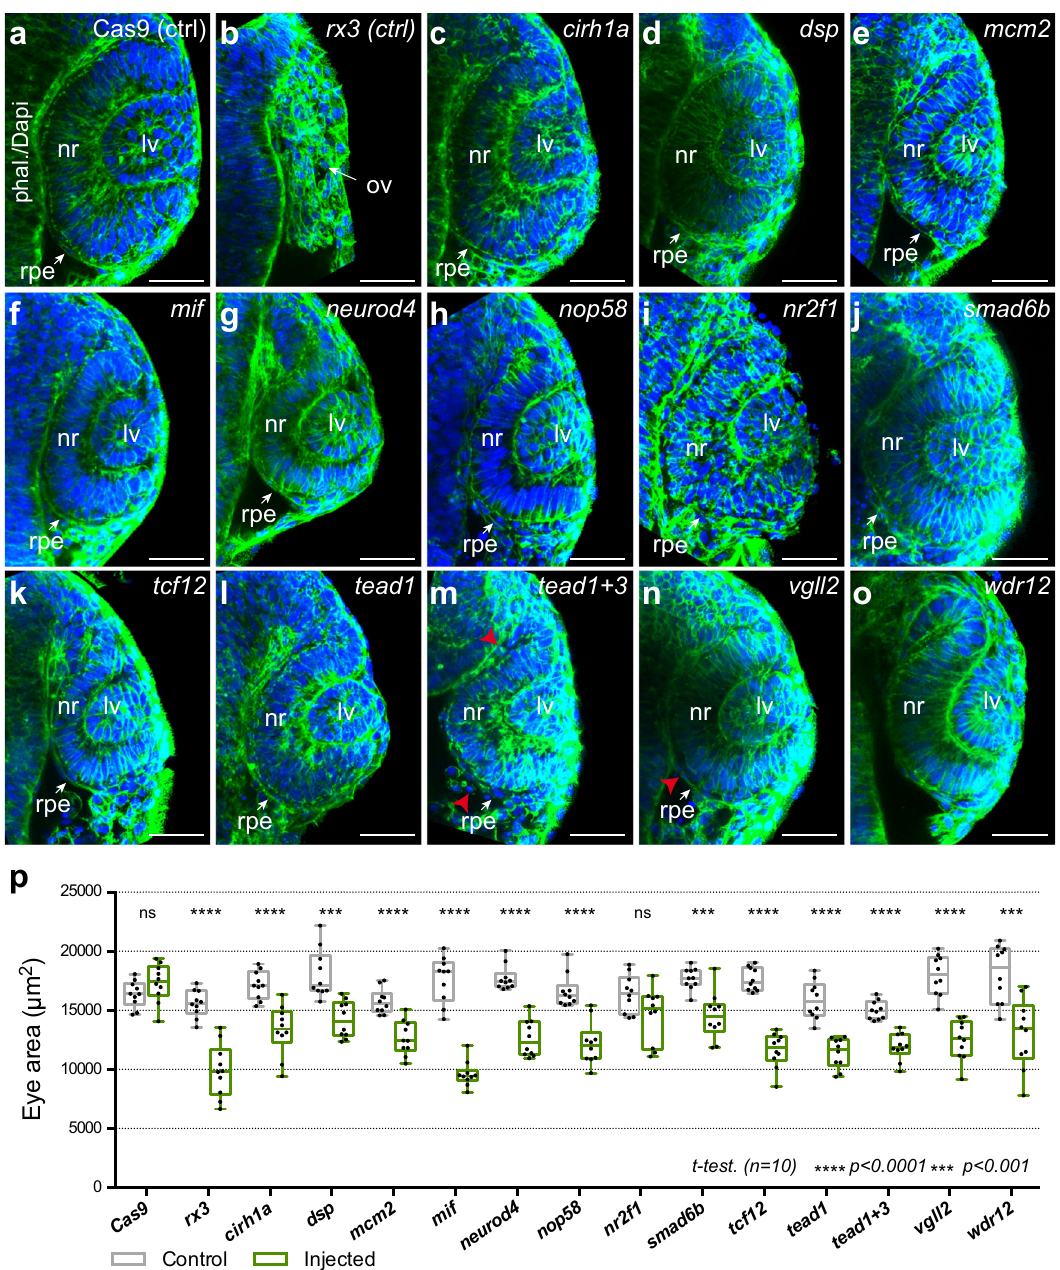
Fig. 8 Optic cup architecture and size quanti fi cation in candidate gene crispant embryos. a – o Representative optical sections through the optic cup of crispant 24 hpf embryos. Phalloidin/DAPI staining reveals tissue organization of control embryos injected only with Cas9 ( a ), with sgRNAs directed against rx3 ( b ), or with sgRNAs for the different candidate genes (indicated in ( c ) – ( o )). Note that, in contrast to rx3 crispant embryos, the optic cup is formed in all cases. However, quantitative analysis of eye area ( p ) reveals a signi fi cant reduction of optic cup size for all candidates tested with the exception of nr2f1 . Individual values ( n = 10) are plotted in front of standard box-and-whiskers (Two-tailed T -test); *** = p < 0.001, **** = p < 0.0001. p values: cas9 = 0.161; rx3 = 1.15e − 6; crh1a = 8.67e − 5; dsp = 1.82e − 4; mcm2 = 3.09e − 5; mif = 1.05e-9; neurod4 = 9.00e − 8; nop58 = 8.09e − 6; nr2f1 = 0.053; smad6b = 2.25e − 4; tcf12 = 2.71e − 9; tead1 = 1.62e − 6; tead1 + 3 = 1.15e − 6; vgll2 = 9.15e − 7; wdr12 = 5.00e − 4. Abnormal morphology of the RPE cells (m,n) is indicated (red arrowheads). ov optic vesicle, lv lens vesicle. Bar = 50 µ m. Source data are provided as a Source Data fi le. See also Supplementary Figs. 9 and